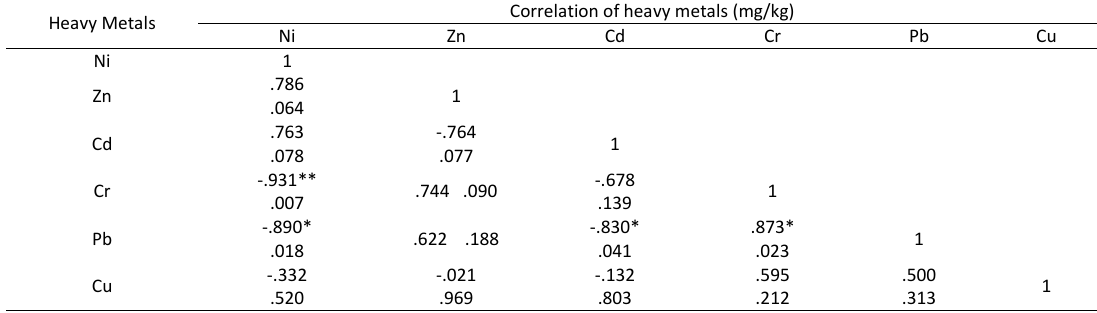
Table 7: Correlation between the selected heavy metals and farmland at 20 – 40cm Depth Heavy Metals